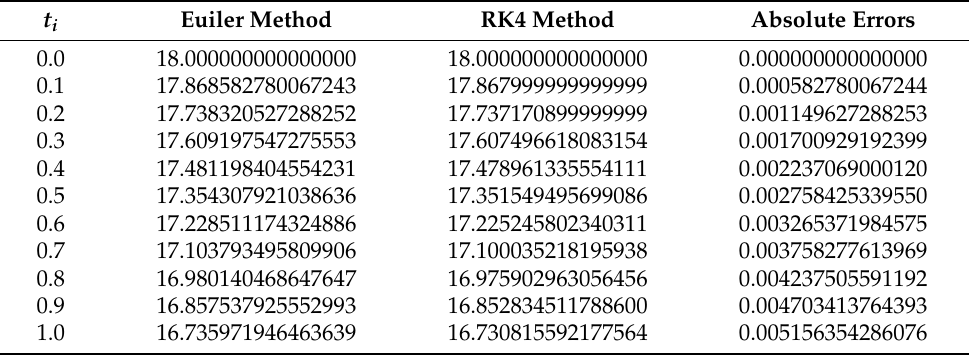
Table 5. Comparison between the results of the Euler method and RK4 method for R ( t )